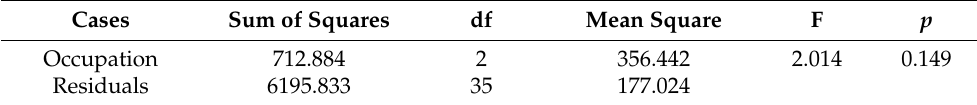
Table 3. ANOVA on three factors: 3 (Occupation: Employed, Student, Unemployed).